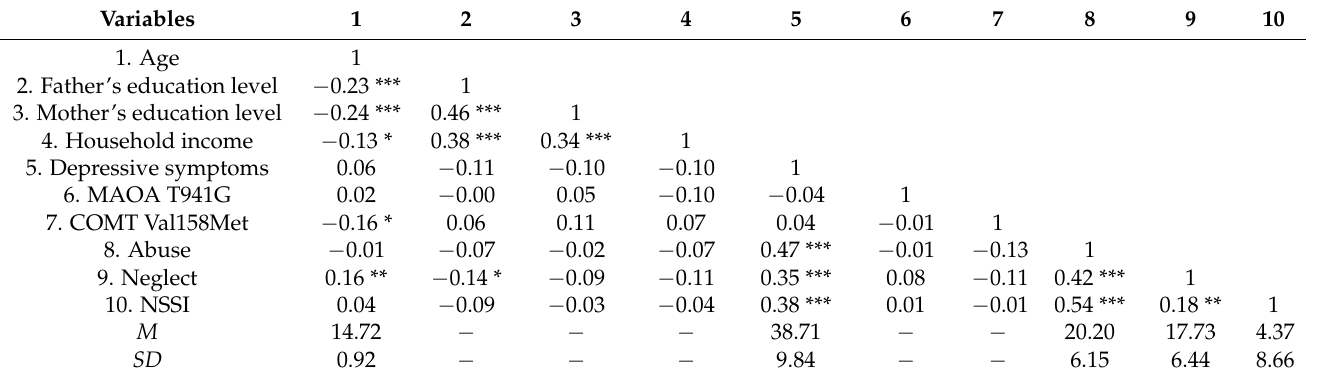
Table 1. Correlations, means, and standard deviations among primary variables.